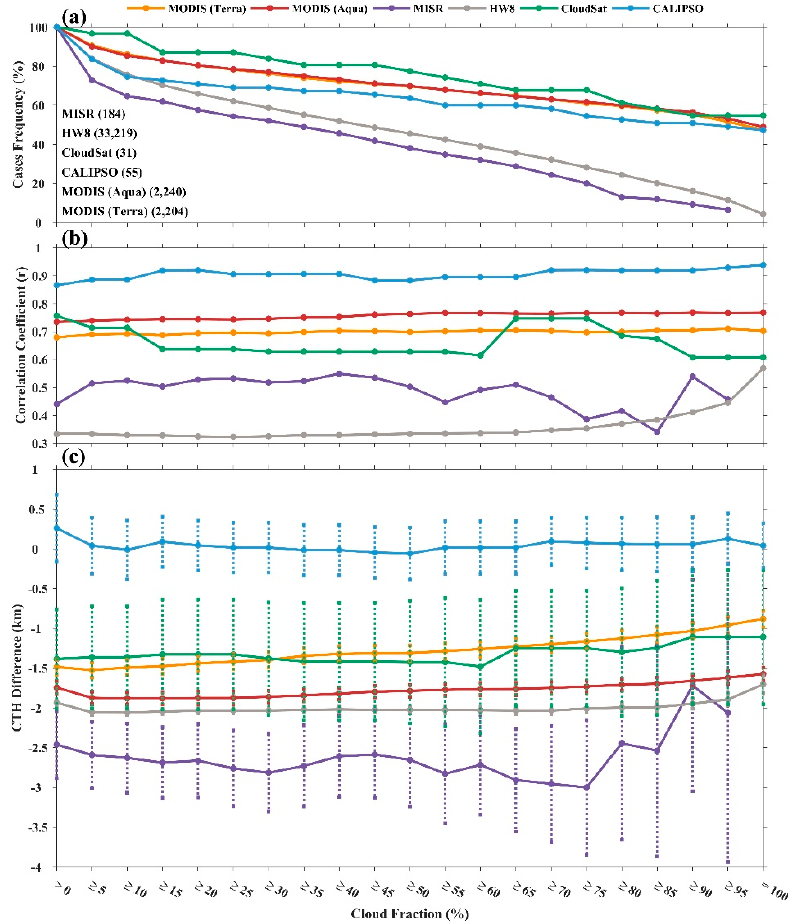
Figure 10. Same as Figure 6 but for overlapping clouds.